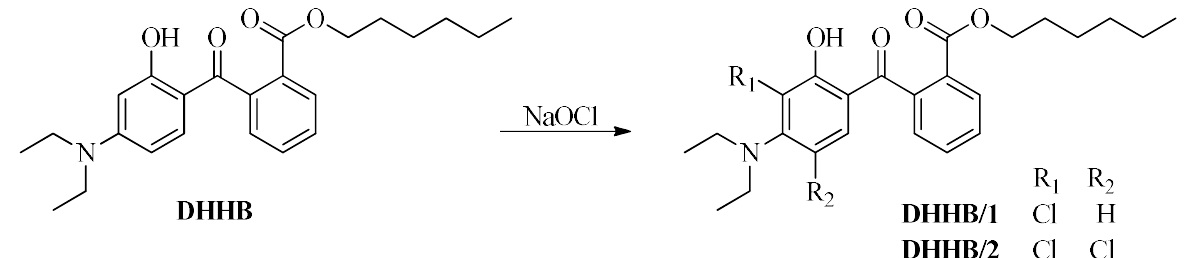
Figure 2. Disinfection by-products from DHHB chlorination.